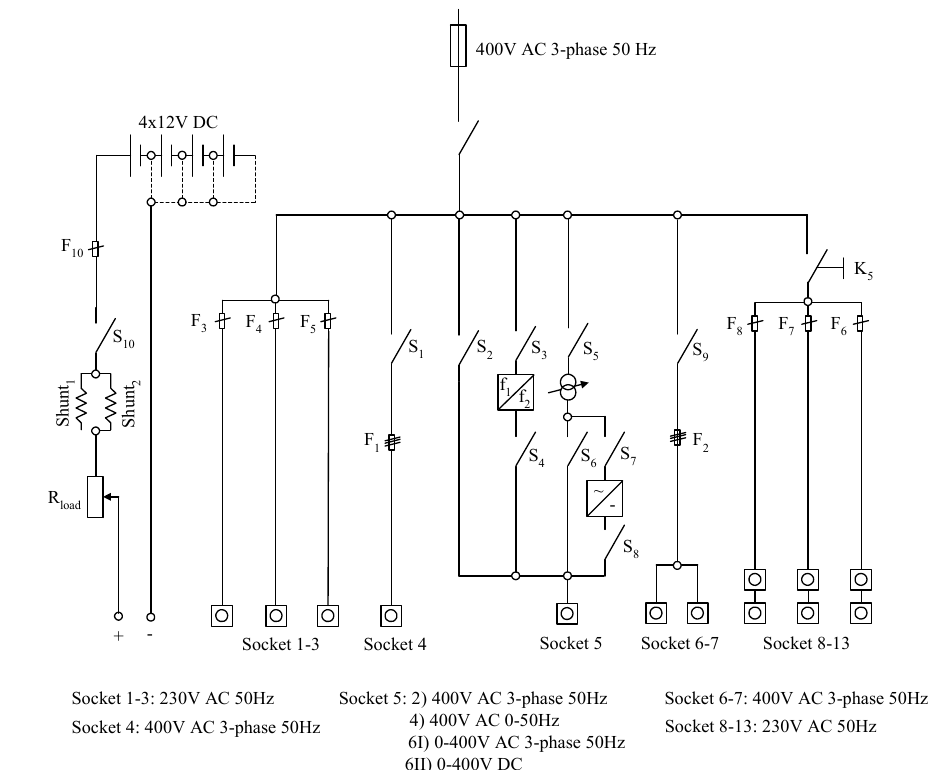
Figure 10. Wiring diagram of the switch cabinet and control panel (diagram 1).